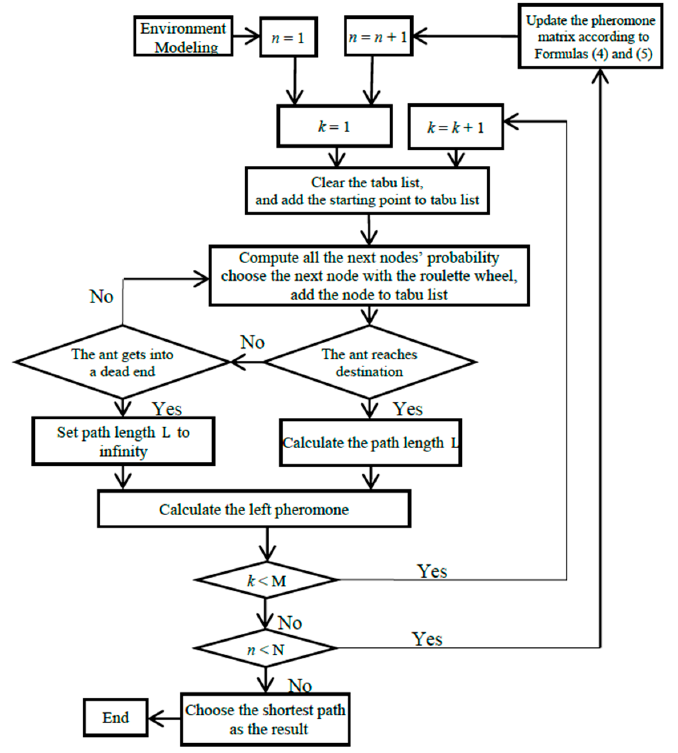
Figure 5. Chart of welding robot collision free path optimization.